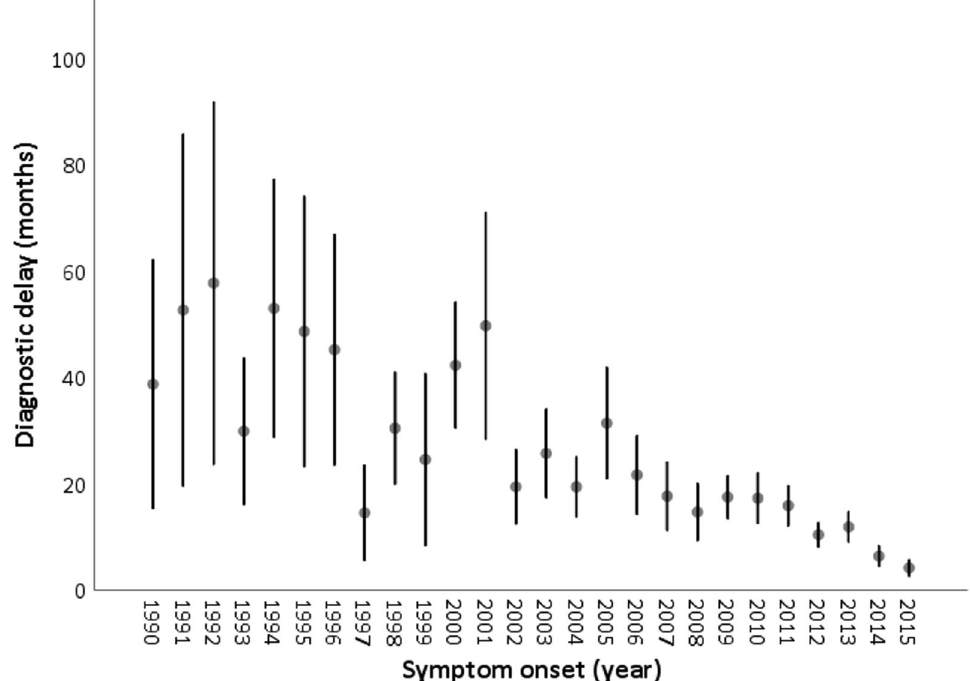
Fig. 1 Rheumatoid arthritis diagnostic delay (months) according to the year of symptoms onset in Brazil. Note : The dots and bars represent the point estimates and 95% confidence intervals for the means,